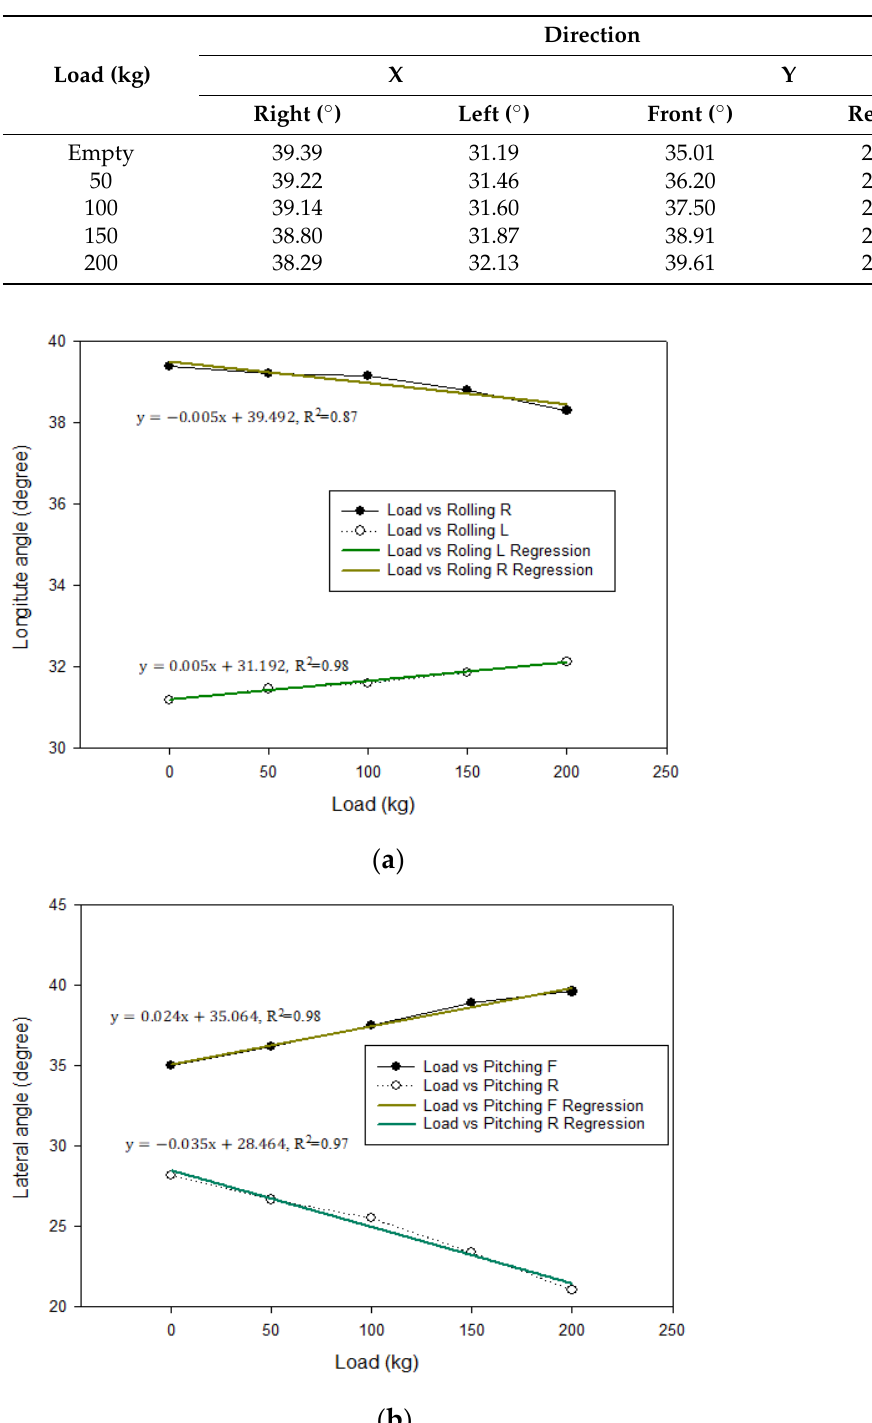
Table 3. Overturning angle of the pepper harvester.